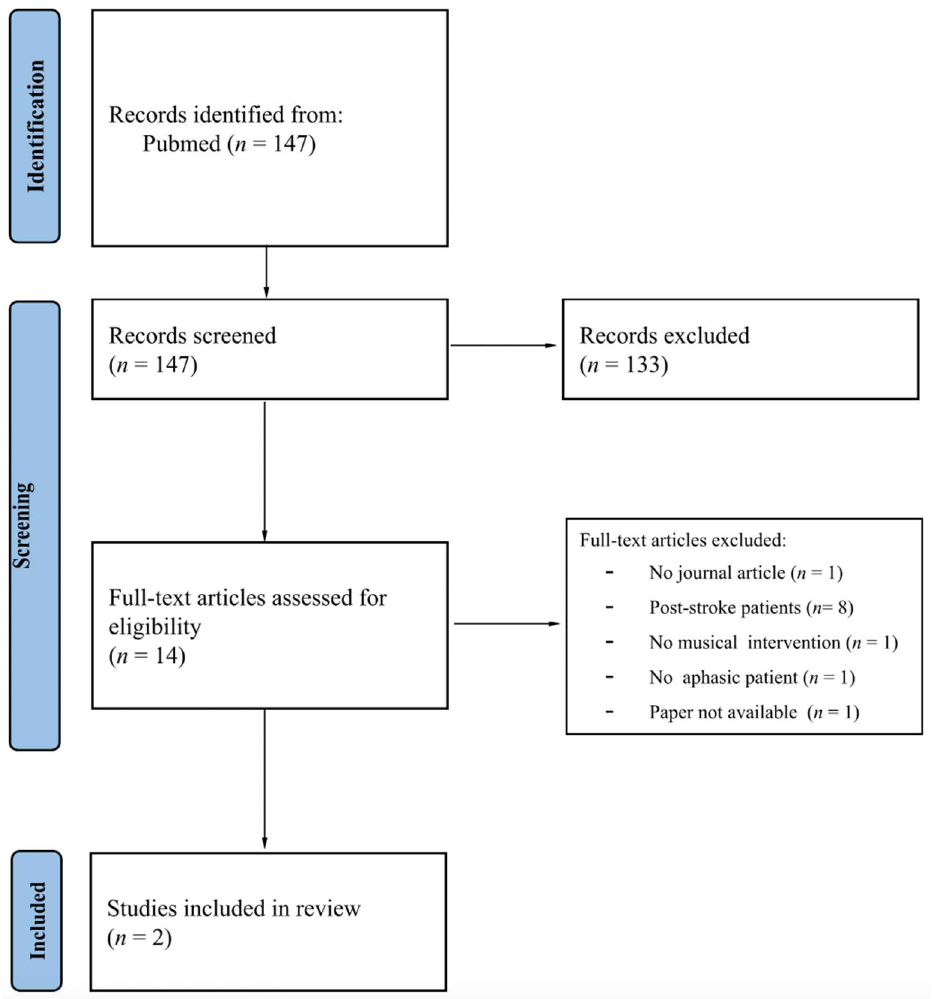
Figure 1. Modified version of the PRISMA diagram flow of the review.